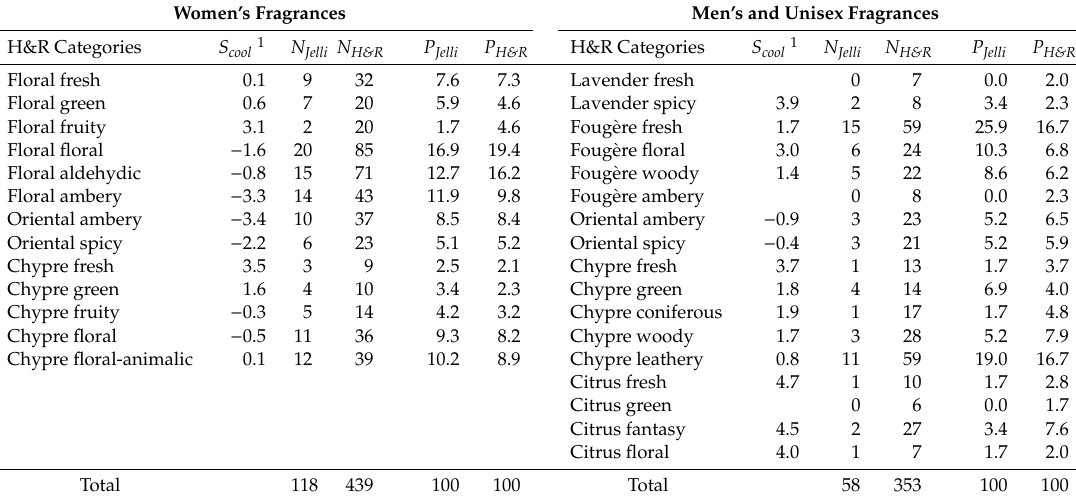
Table 2. Classification of the 176 fragrances used by Jellinek [1,27] (118 women’s, 56 men’s, and 2 unisex) according to the H&R categories [3]: number of fragrances listed under each category ( N Jelli ) and relative frequency as a percentage ( P Jelli ). The absolute frequency ( N H&R ) and the relative frequency ( P H&R ) of fragrances included in each category of the H&R guide are also indicated. Women’s Fragrances Men’s and Unisex